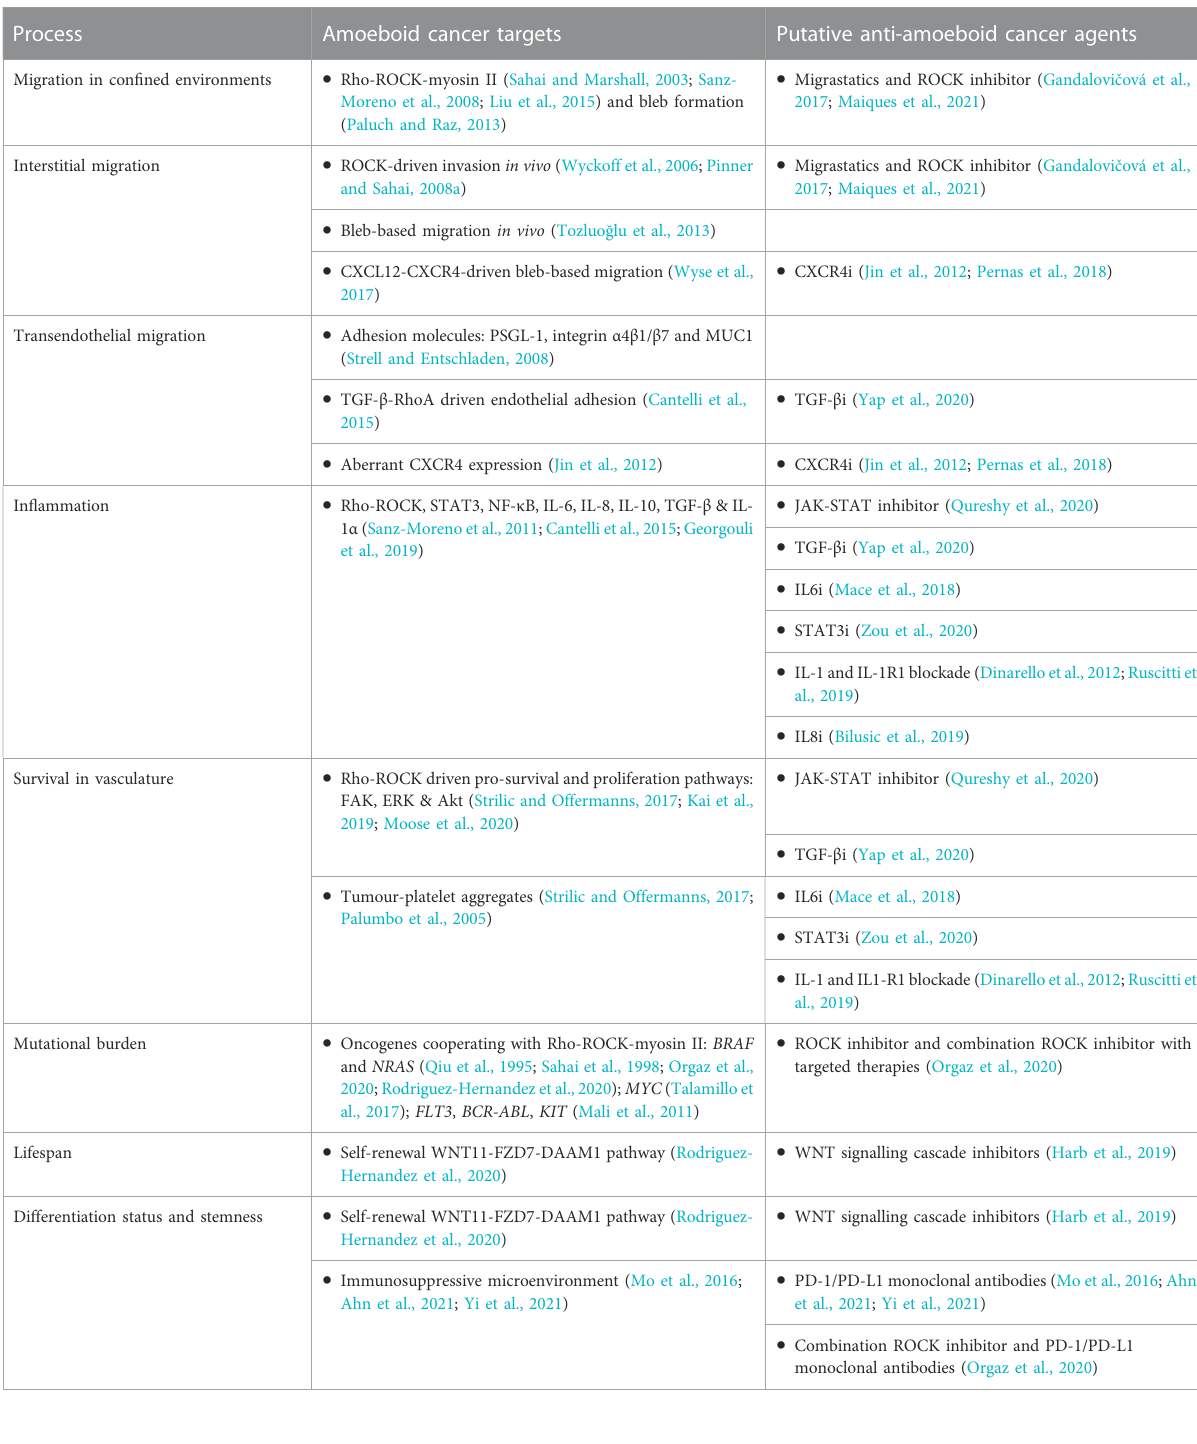
TABLE 1 Putative targets for amoeboid cancer